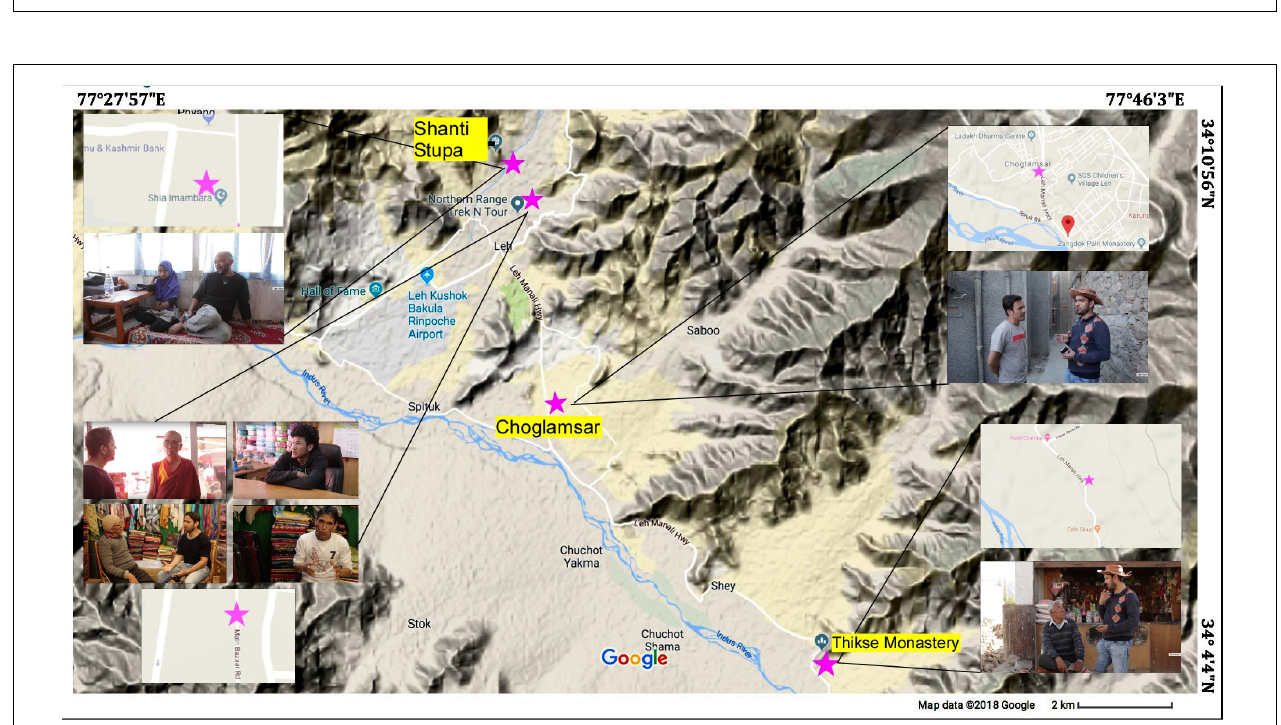
FIGURE 2 | The Google terrain image shows the location of field interaction with locals in Leh. The satellite image is retrieved from Google maps on 20th July 2018. A written consent form is signed by each participant that is interviewed during the fieldwork in Jammu and Kashmir (a few examples are shown here).